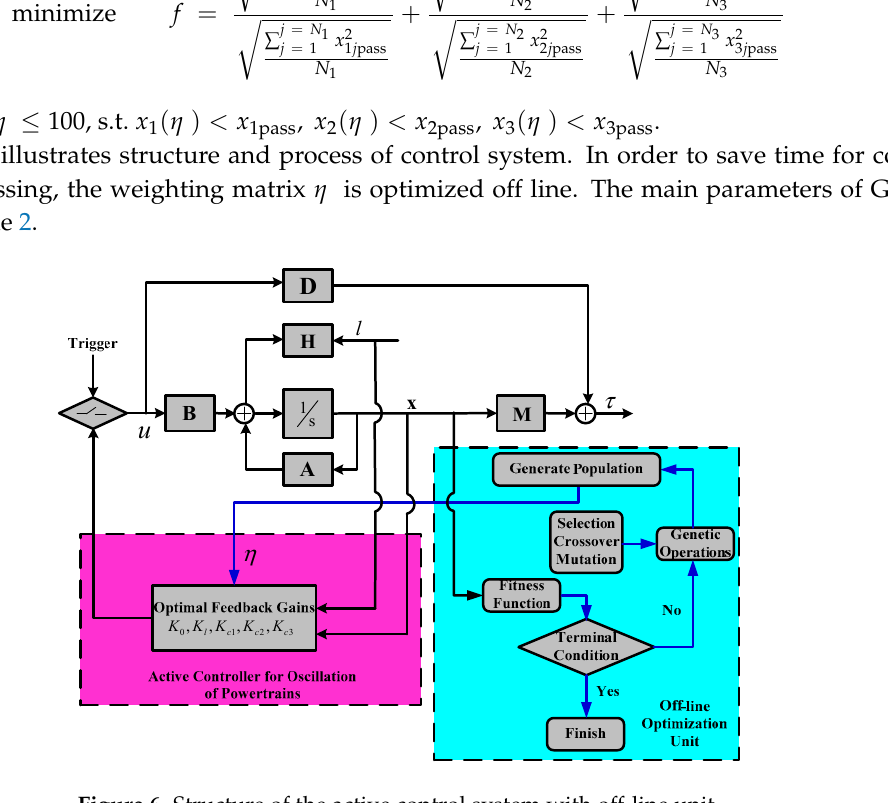
Figure 6. Structure of the active control system with off-line unit.